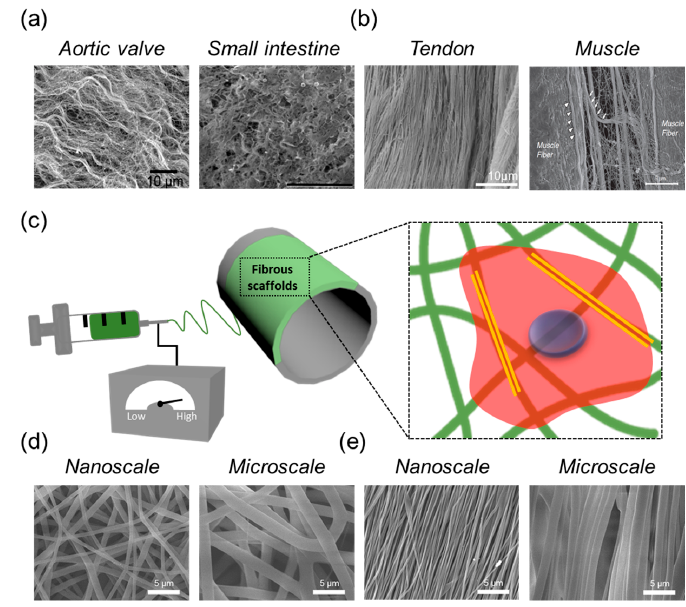
Figure 1. Scanning electron microscope (SEM) images of a natural extracellular matrix (ECM) in distinct types of tissues with ( a ) isotropic direction and ( b ) anisotropic direction [30–33]; ( c ) Schematic illustration of the electrospinning process; ( d ) Representative SEM images of fibrous scaffolds with a controllable fibrous scale with ( d ) randomly and ( e ) aligned fibrous deposition via electrospinning.